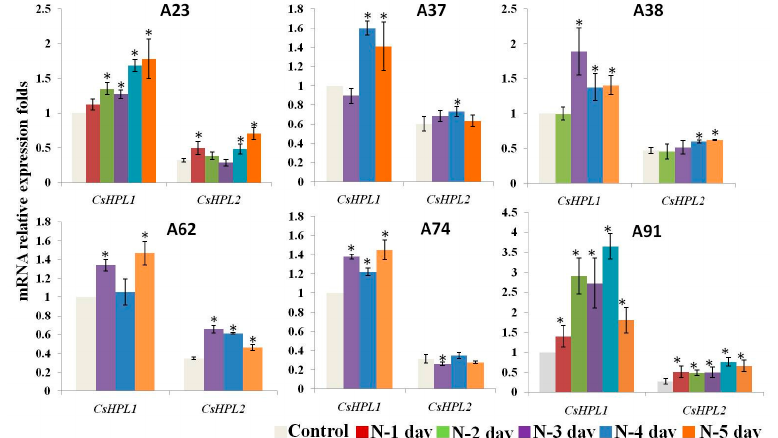
Figure 9. Expression profiles of HPL genes in six inbred cucumber leaves during N-deficient treatments. Leaves were sampled at 1, 2, 3, 4 and 5 d after N-deficient treatments. The map has been generated based on the fold-change values of CsHPLs in the treated samples when compared with its unstressed control samples. The CsHPL1 expression level of control was considered as one-fold. Bars present means ± standard deviations. * means significant difference from control at p < 0.05. Values are means of three biological replicates with three technical replicates.